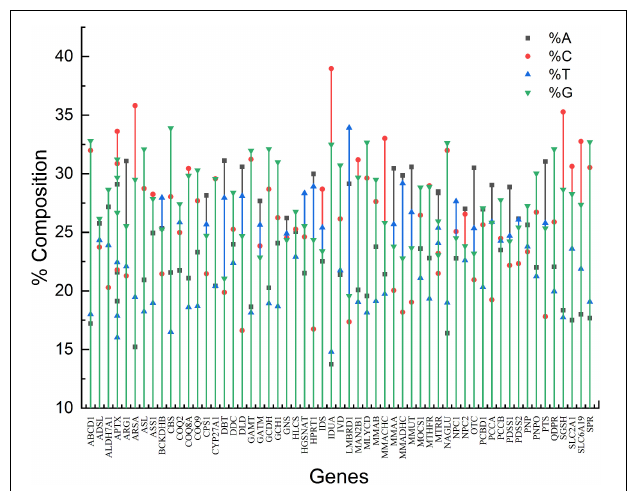
FIGURE 1 | Stem graph for nucleotide composition of genes envisaged in present